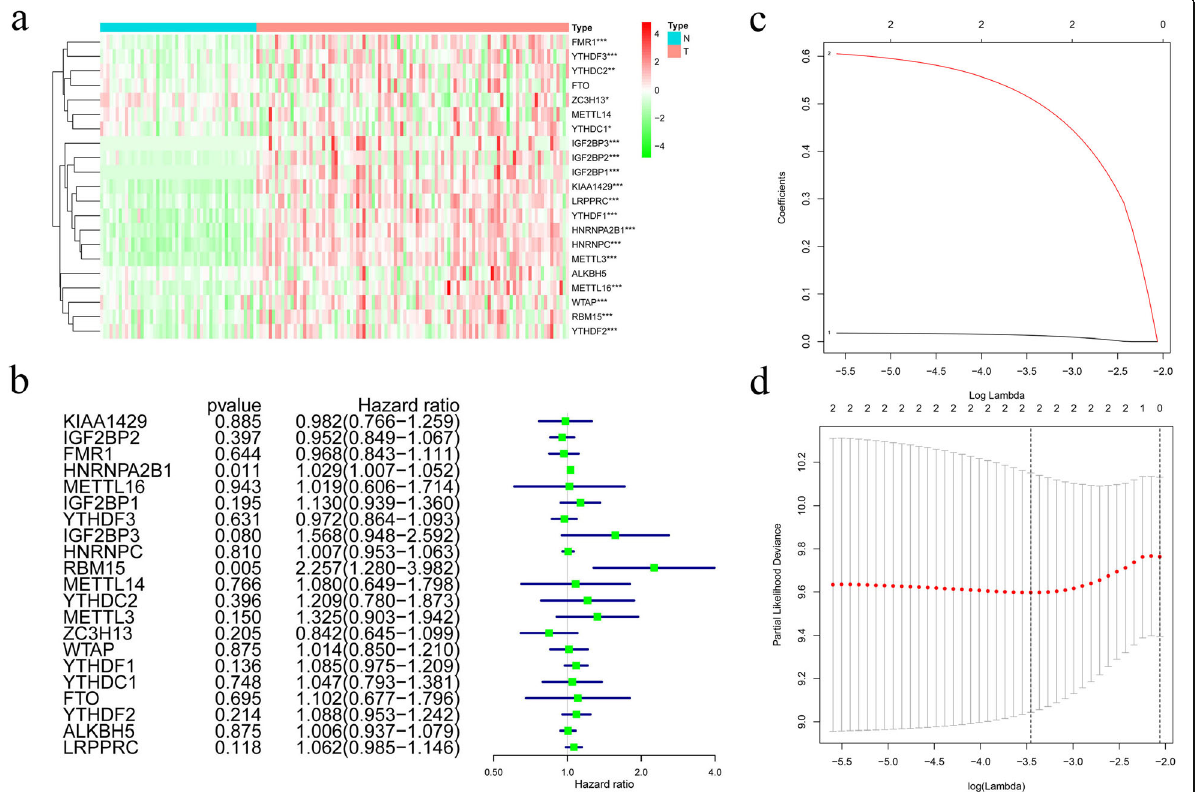
Fig. 1 a Heatmap of m6A-related gene expression in 374 HBV-related tumor tissues and 50 normal tissues. “ * ” represents statistical significance at P < 0.05, “ ** ” represents statistical significance at P < 0.01, and “ *** ” represents statistical significance at P < 0.001. b Forest plot of the univariate Cox regression analysis in m6A-related genes. c and d Establishment of the Lasso regression